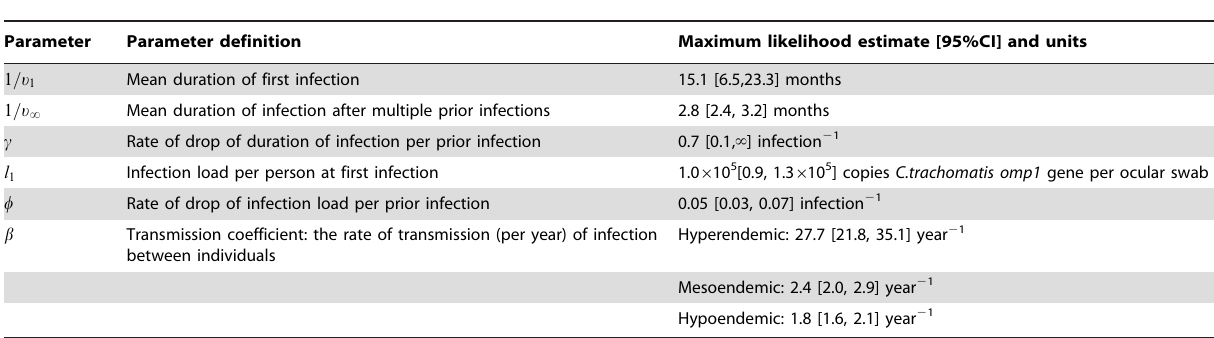
Table 2. Model parameter definitions and